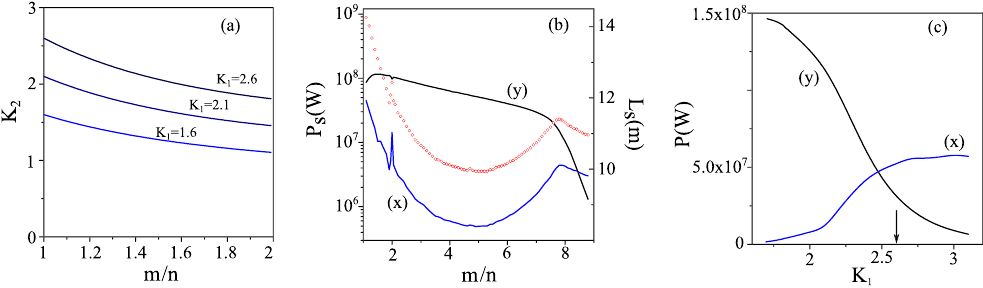
¼ L FIG. 5. (a) K 2 solution of the relation L as a function of m=n and for few values of K 1 . (b) Left axis: in black, first peak value g 1 g 2 of the power P ; in blue, power of the x polarization at L as a function of m=n . Right axis: red circle, saturation length L s s polarization, reaching first the saturation. (c) In blue, power P of x and, in black, y polarizations at varying values of K 1 , with K 2 ¼ 2 . 1 and m=n ¼ 1 . 5 . The powers are both evaluated at the first peak of saturation of the y polarization, which is going first at saturation in this regime. The arrow indicates the point where the two gain lengths are the same.